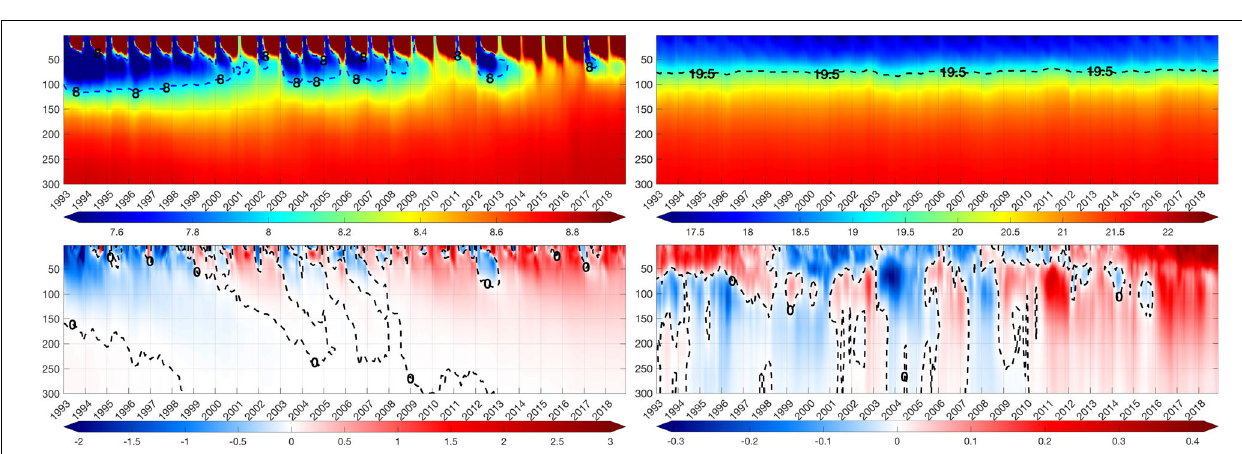
FIGURE 8 | Time versus depth diagrams of the monthly basin-averaged temperature in ◦ C (top left), anomaly of temperature in ◦ C (bottom left), monthly basin-averaged salinity in PSU (top right), and anomaly of salinity in PSU (bottom right). The monthly anomaly estimates considered the climatological period 1993–2014 of each corresponding month. The blue dashed line indicates the mean position of the 8 ◦ C isotherm (top left), whereas the dashed black line represents the isoline of 19.5 PSU (top right) and null anomaly (bottom